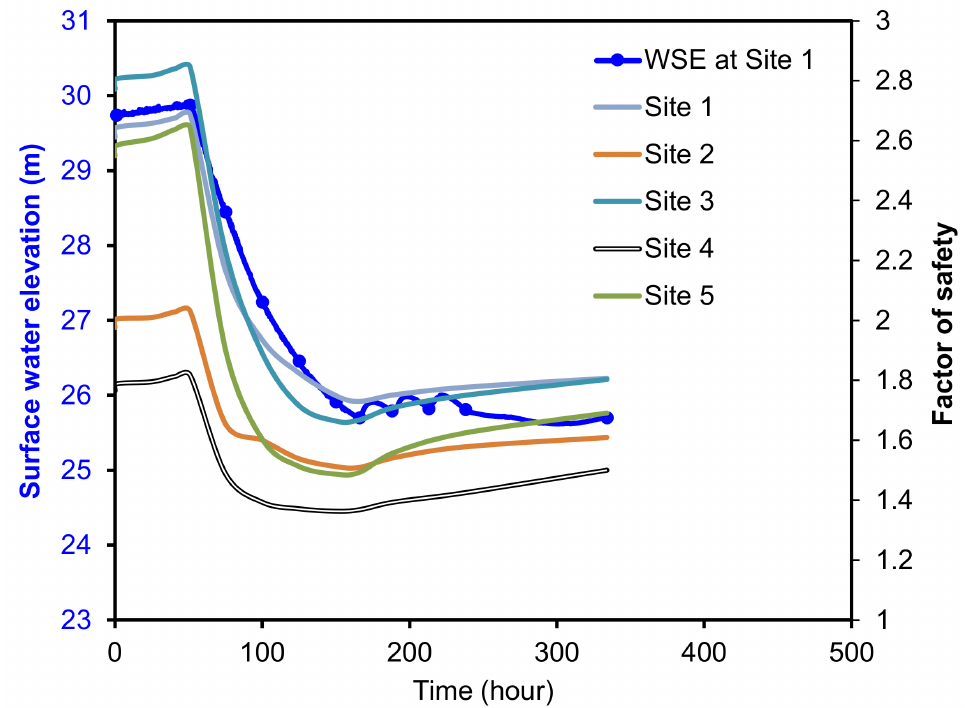
Figure 13. Changes in factor of safety with time during a transient drawdown